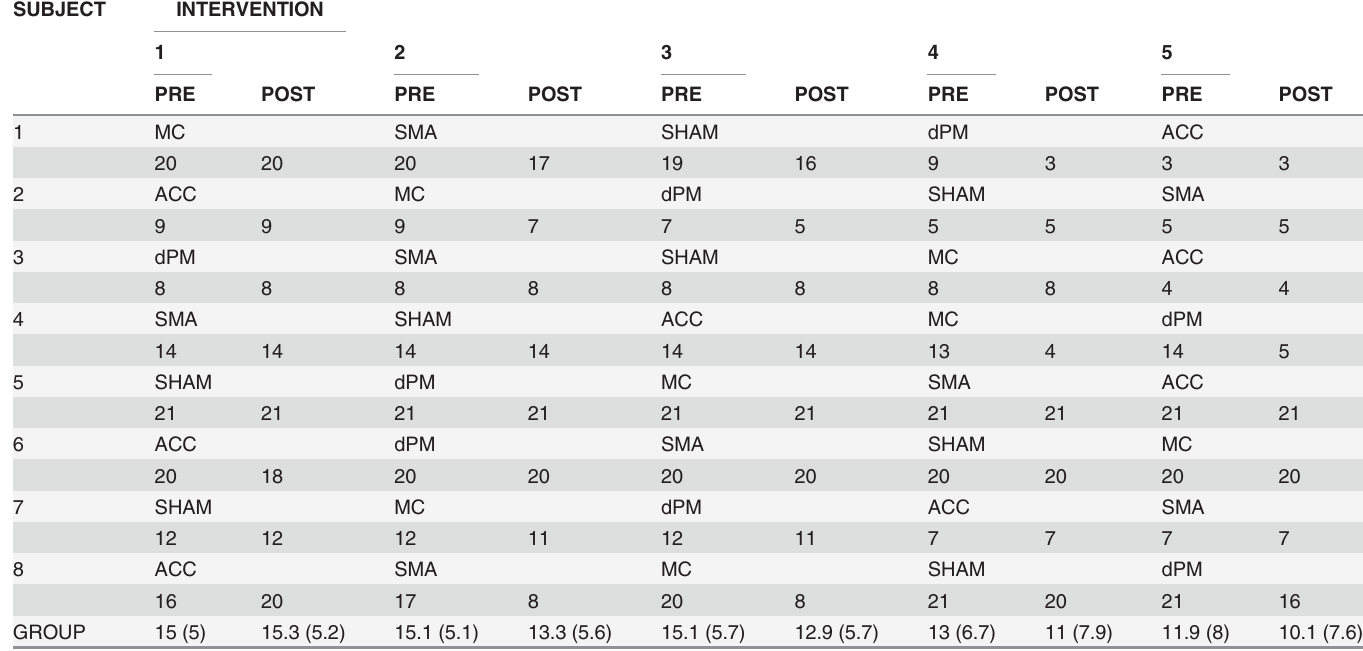
Table 2. Demographic, clinical features and baseline severity, and raw TWSTRS severity scores by